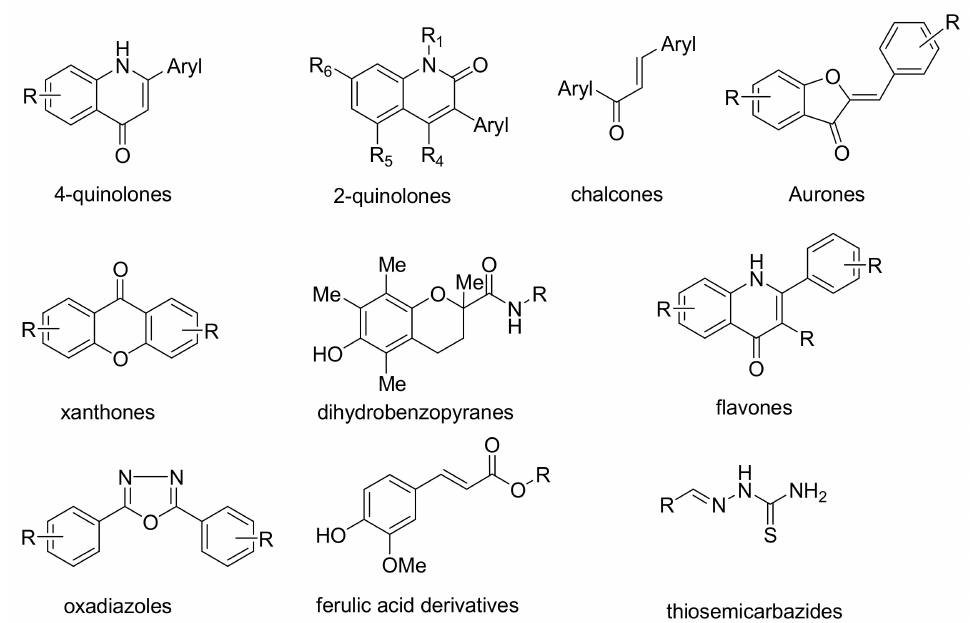
Figure 1. Sca ff olds of the derivatives (library of 140 compounds) tested in the primary screen (at 10 and 100 µ